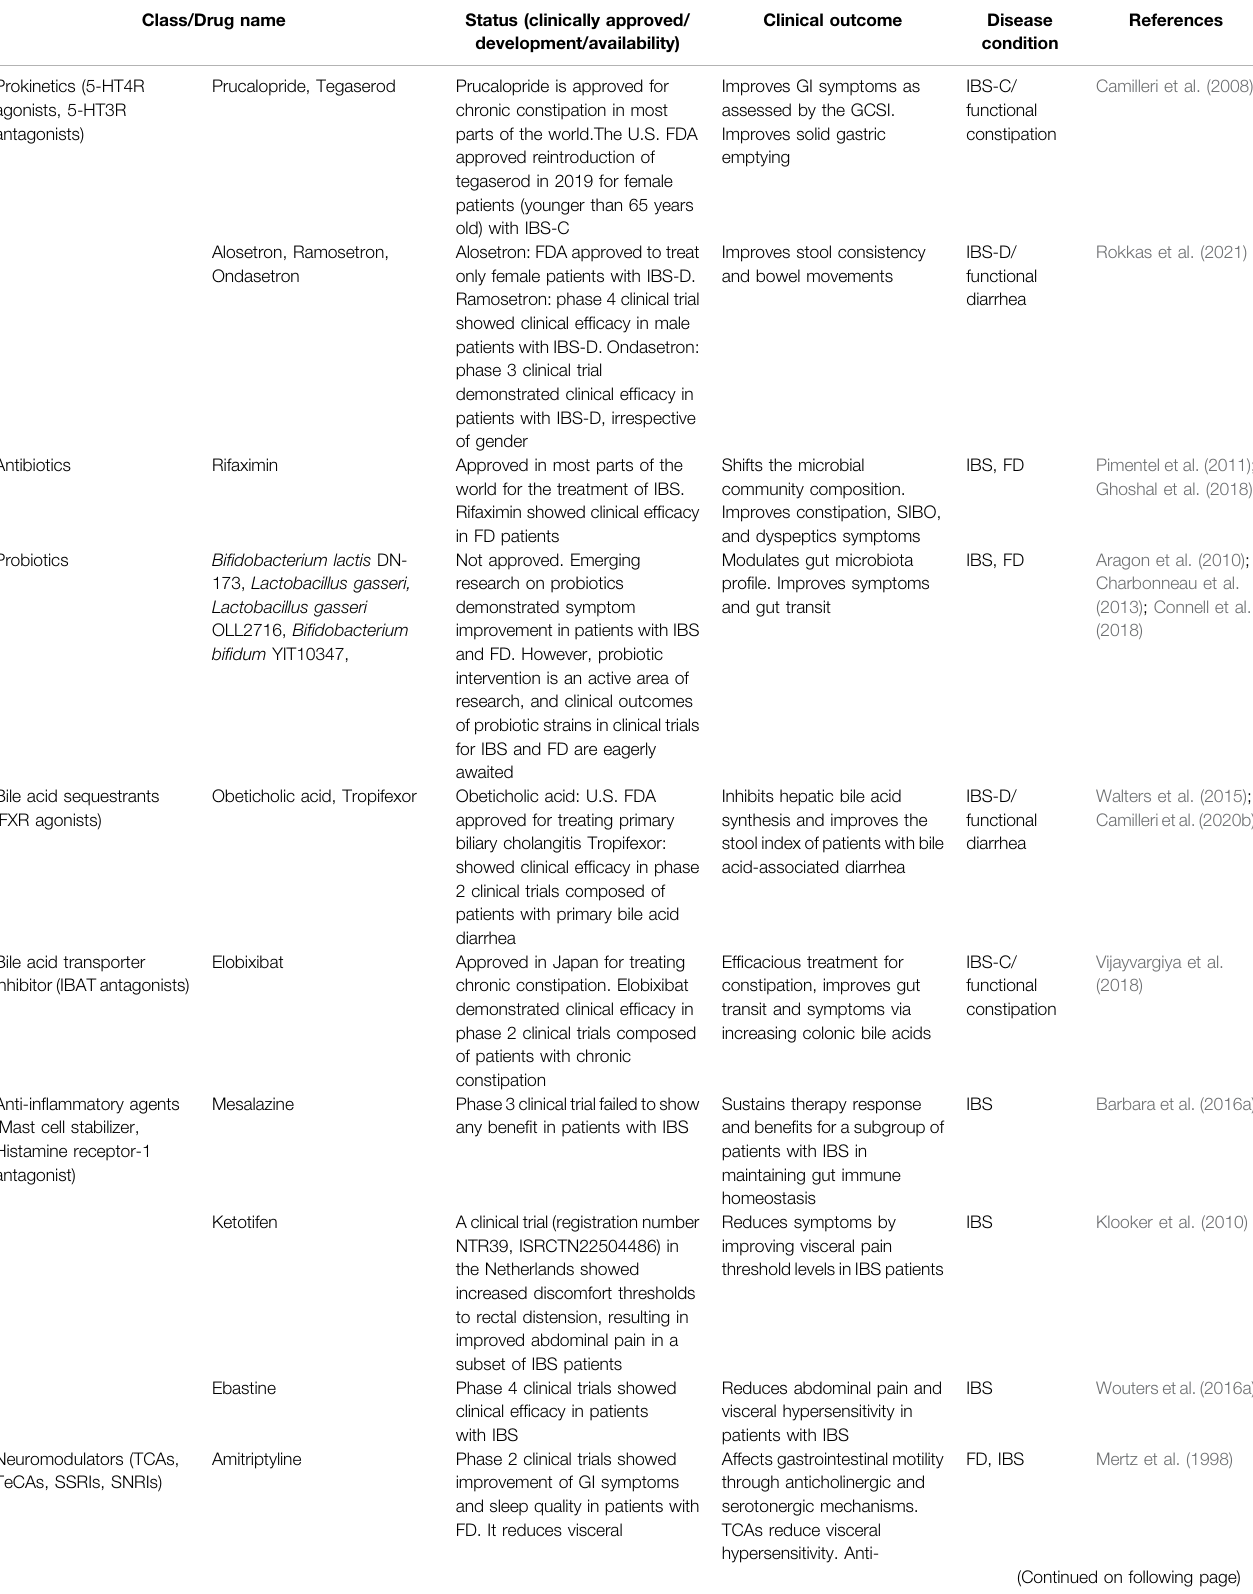
TABLE 3 | Currently available pharmacological agents for bowel